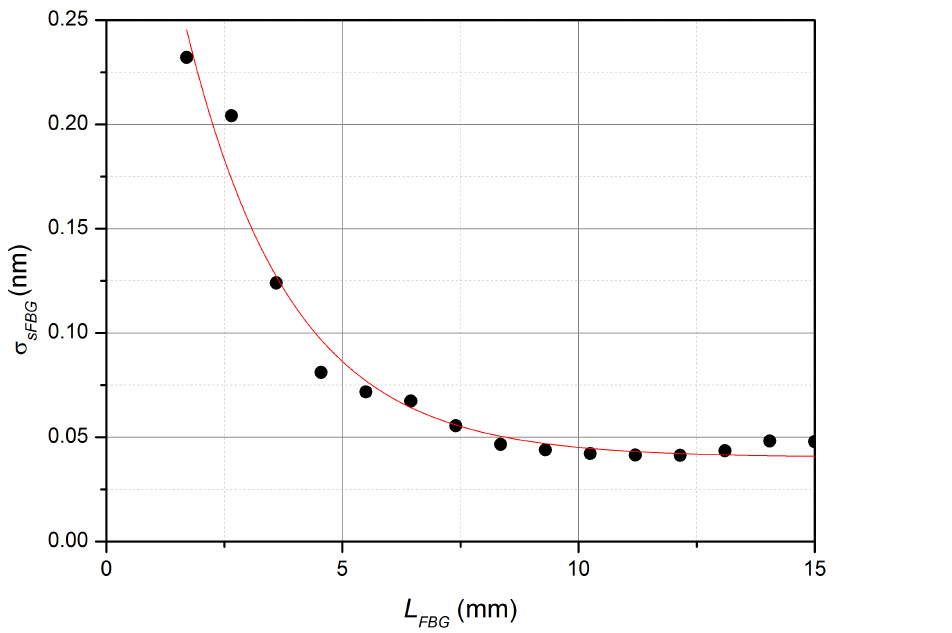
Figure 6. Dependence of the half-width of the reflected radiation spectrum on the FBG length (experiment and approximation by decaying exponential function with the constant